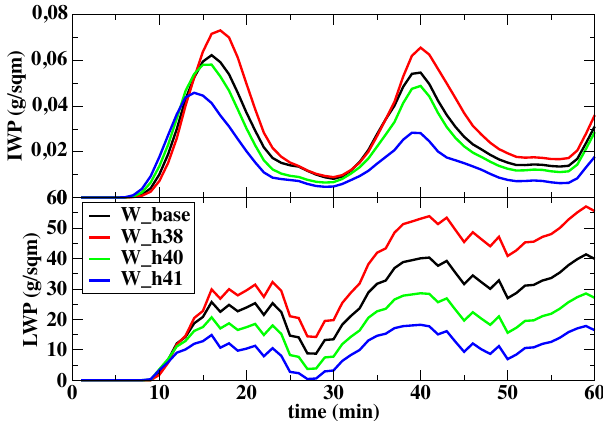
Figure 10. Liquid (lower panel) and ice water paths (upper panel) for case 1. Comparison of the different values for h bot